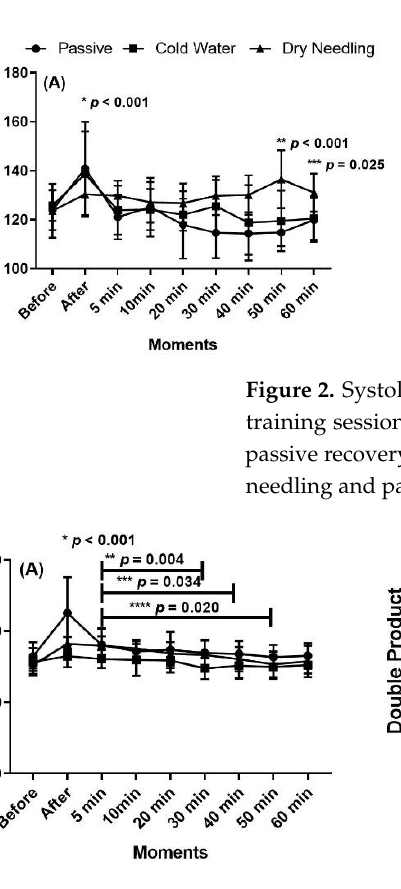
Figure 3. Heart rate ( A ) in Beats for minutes (BPM), double product ( B ) and myocardial oxygen (MVO 2 ) ( C ), before and until 60 min after the training session followed by the passive recovery with the three recovery methods. * Difference between passive recovery, dry needling and cold-water. ** Difference with dry needling between minute 5 and minute 40. *** Difference with dry needling between minute 5 and minute 50. **** Difference with dry needling between minute 5 and minute 60.